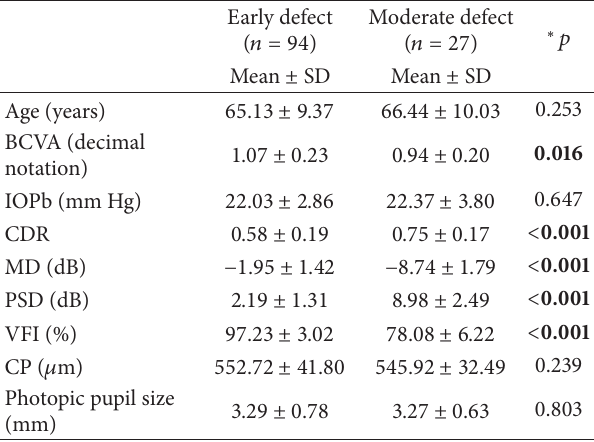
Table 2: Descriptive and clinical data for 121 glaucoma patients classified into two groups according to disease severity (Hodapp- Parrish-Anderson